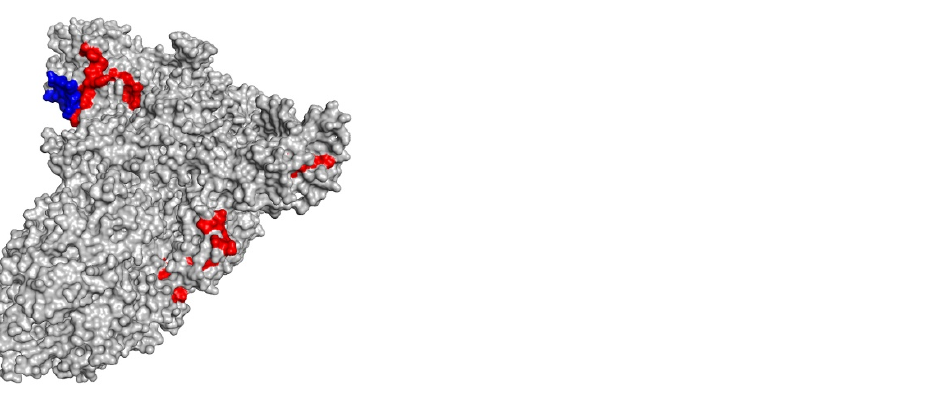
Figure 2. 3D representation of the spike (S) protein (gray) with highlighted class I-restricted (red) and class II-restricted epitopes (blue).